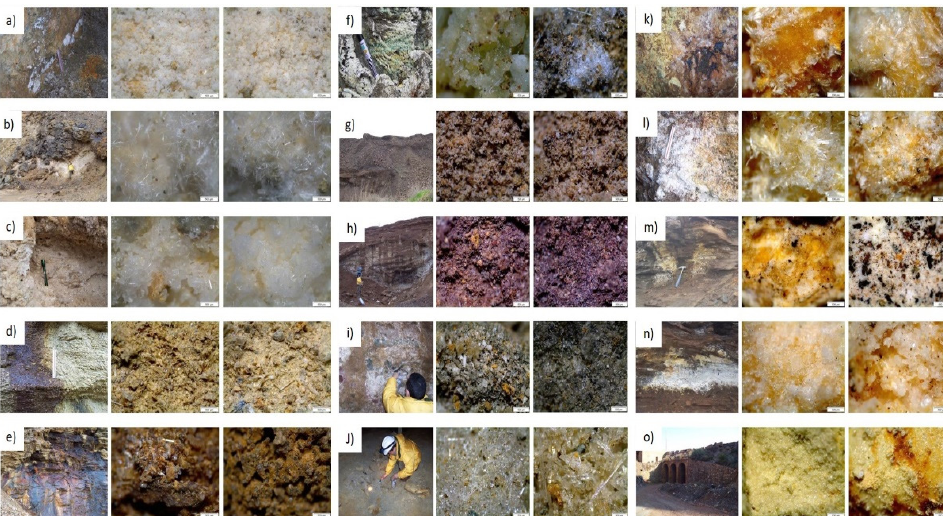
Figure 2 . Two stereo microscopic observations of the salt efflorescences evaluated in this work are shown on the right, along with sampling sites (on the left). Images on the right have a 40× magnification and are scaled to 500 µm long. SS1 ( a ), SS2 ( b ), SS3 ( c ), SS4 ( d ), SS5 ( e ), SS6 ( f ), SS7 ( g ), SS8 ( h ), SS9 ( i ), SS10 ( j ), SS11 ( k ), SS12 ( l ), SS13 ( m ), SS14 ( n ), SS15 ( o ).